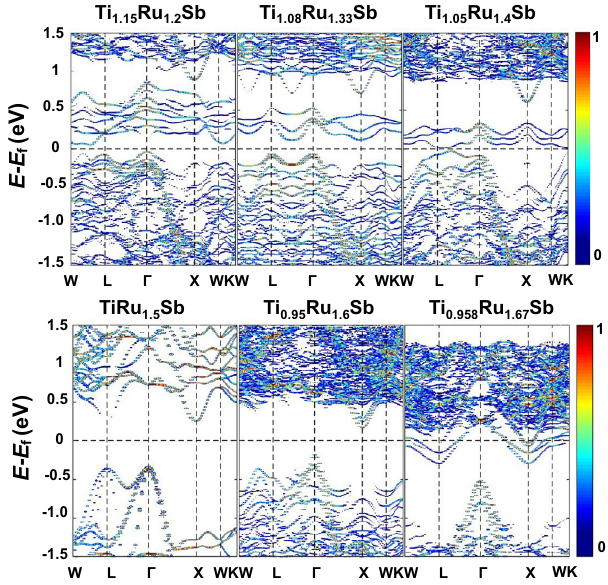
Fig. 5 Electronic band structures of TiRu 1 + x Sb materials. The color scale represents the band weight at ( ~ k i ; ε j